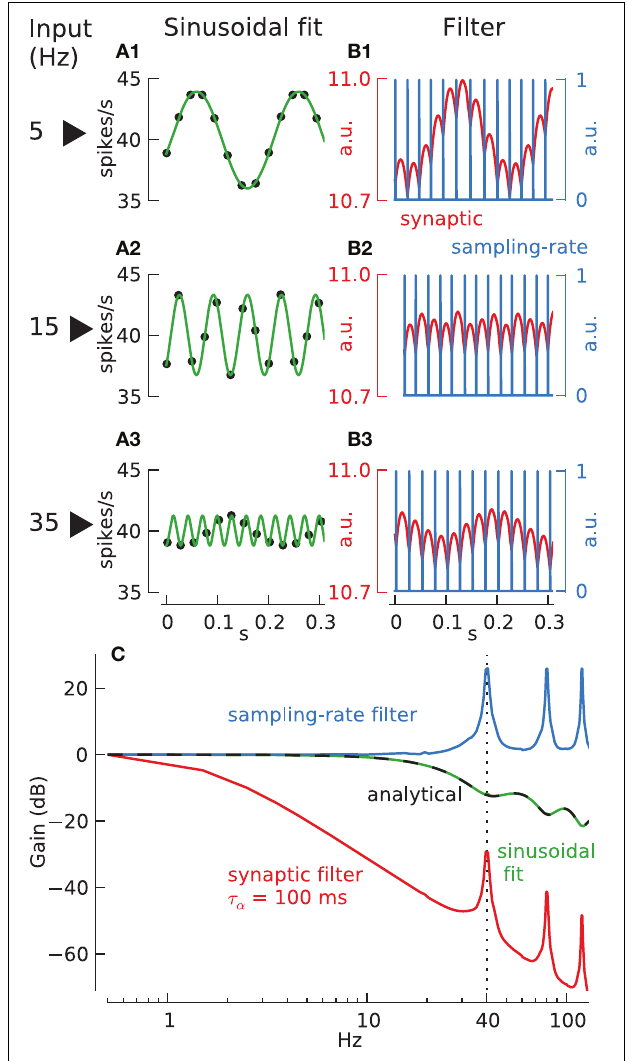
FIGURE 1 | Different methods to compute neuronal transfer function from spike times. (A) Sinusoidal fit method: spike rate (black dots) and fitted sinusoids (green lines) for stimulation of integrate-and-fire neuron ( τ = 15 . 7ms) with current modulated at 5Hz (A1) , 15Hz (A2) , and 35Hz (A3) . (B) Filter method: spike times, resulting from stimulation of integrate-and-fire neuron as in (A) , with current modulated at 5Hz (B1) , 15Hz (B2) , and 35Hz (B3), are convolved with either an alpha-function (with τ α = 100ms) (red lines), called “synaptic filter,” or a rectangular function (width = 0.025ms, i.e., simulation step size) (blue lines), called “sampling-rate filter.” (C) Resulting transfer function using either sinusoidal fit (green line, analytical function: black dashed line) or filter methods (synaptic, red line; sampling-rate, blue